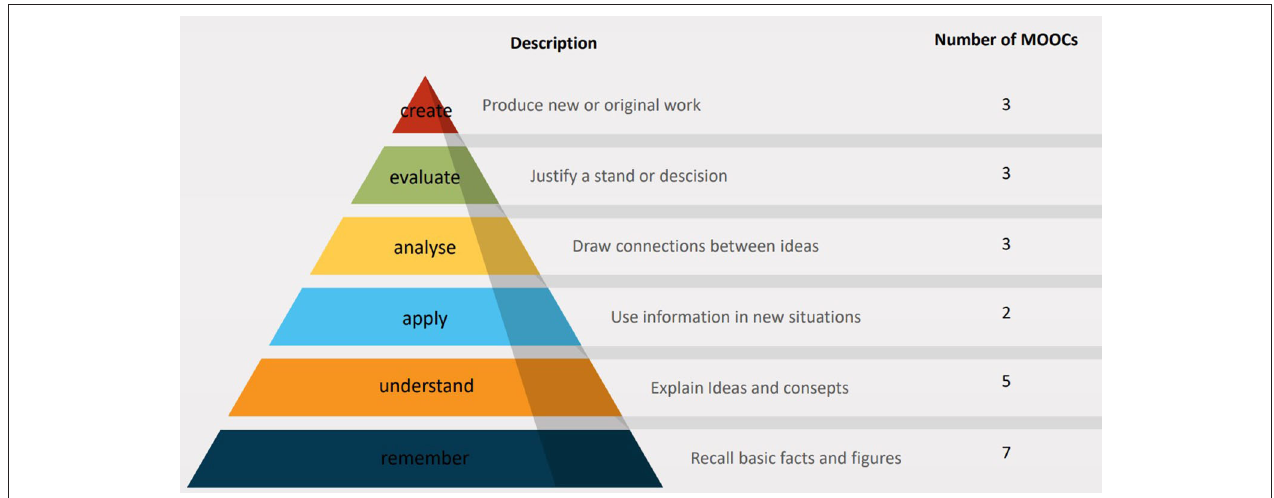
FIGURE 4 | Level of learning across 10 MOOCs according to Blooms’